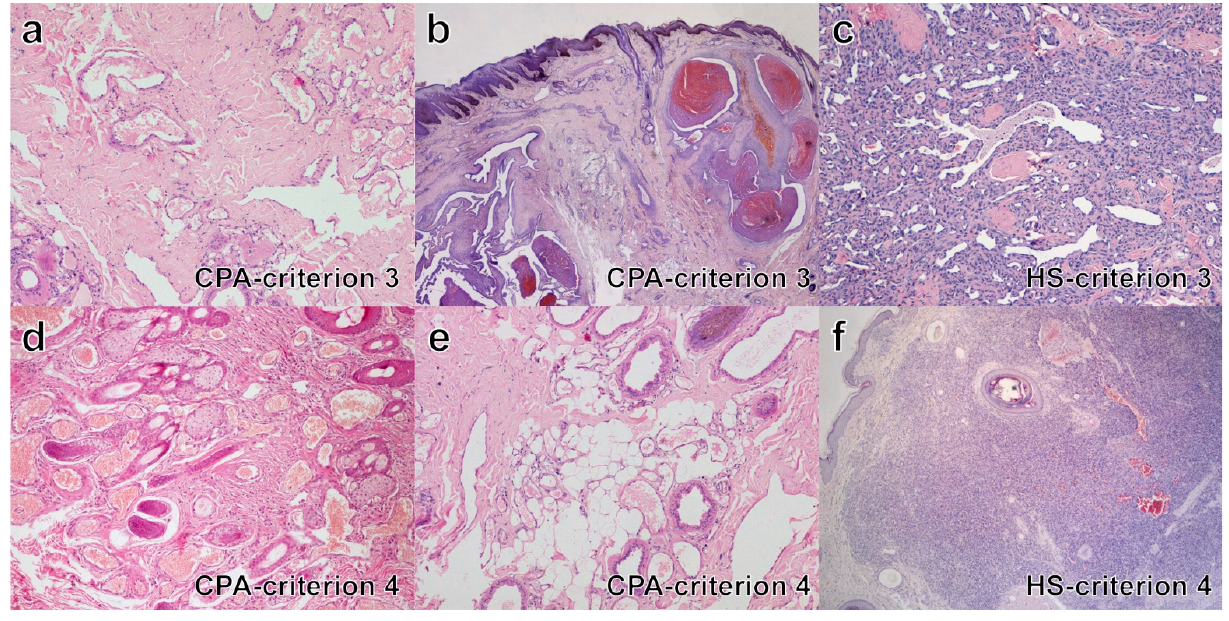
Figure 2. Histopathology in cases of CPA and HS (H&E stain): criteria 3 and 4. ( a ) CRITERION 3, CPA case n. 11: multifocal, lobular vascular growth pattern; ( b ) CRITERION 3, CPA case n. 16: multiple large vessels with endoluminal papillary growth; ( c ) CRITERION 3, HS case n. 10: irregular blood-filled channels and lacunae; ( d ) CRITERION 4, CPA case n. 1: interposed adnexal appendages (follicles, sebaceous glands) between vessels; ( e ) CRITERION 4, CPA, case n. 11: interposed fat and apocrine glands between vessels; ( f ) CRITERION 4, HS, case n. 2: only one follicle within the core of the lesion.